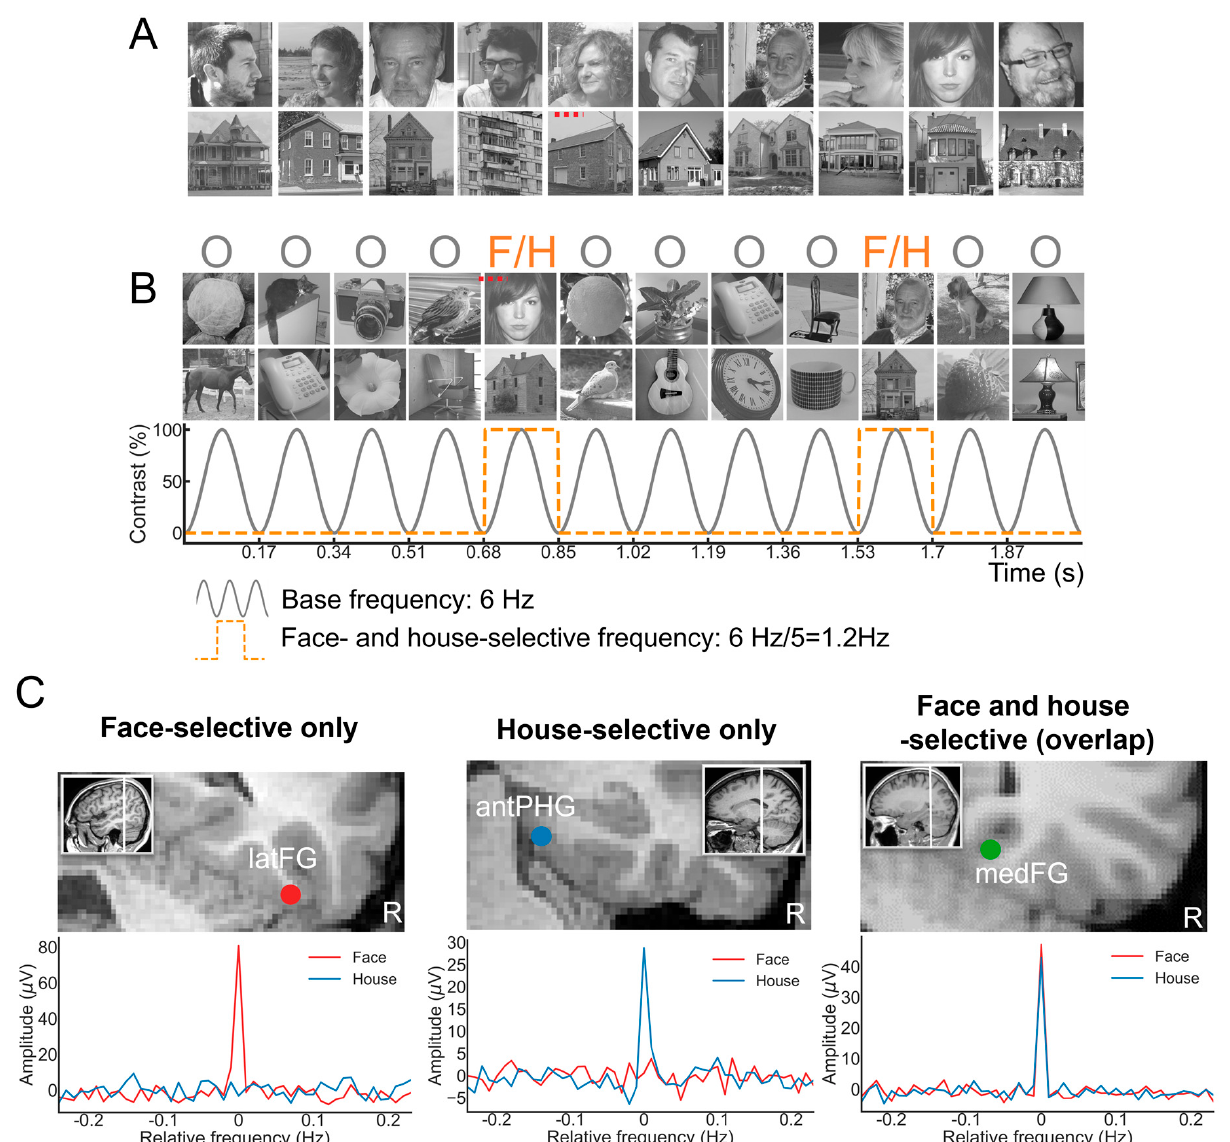
Figure 10. ( A ) Example of natural images of faces and houses used in the experiment of Hagen et al., 2020 [152] (actual face images not shown for copyright reasons). ( B ) Images of living or non-living objects (O) were presented by sinusoidal contrast modulation at a rate of six stimuli per second (6 Hz), with different images of either faces (F) or houses (H) presented in separate sequences at 1.2 Hz. ( C ) Examples of baseline corrected FFT spectra (in different participants) show a face-selective contact with no response to houses at all, a house-selective contact with no response to faces at all, and a contact with face and house-selective responses (overlap